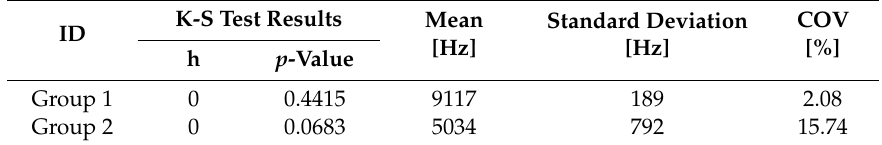
Table 1. Summary of a statistical analysis: K-S test results and mean, standard deviation and coe ffi cient of variation of data sets from two sound and fire-damaged concrete slabs in this study.